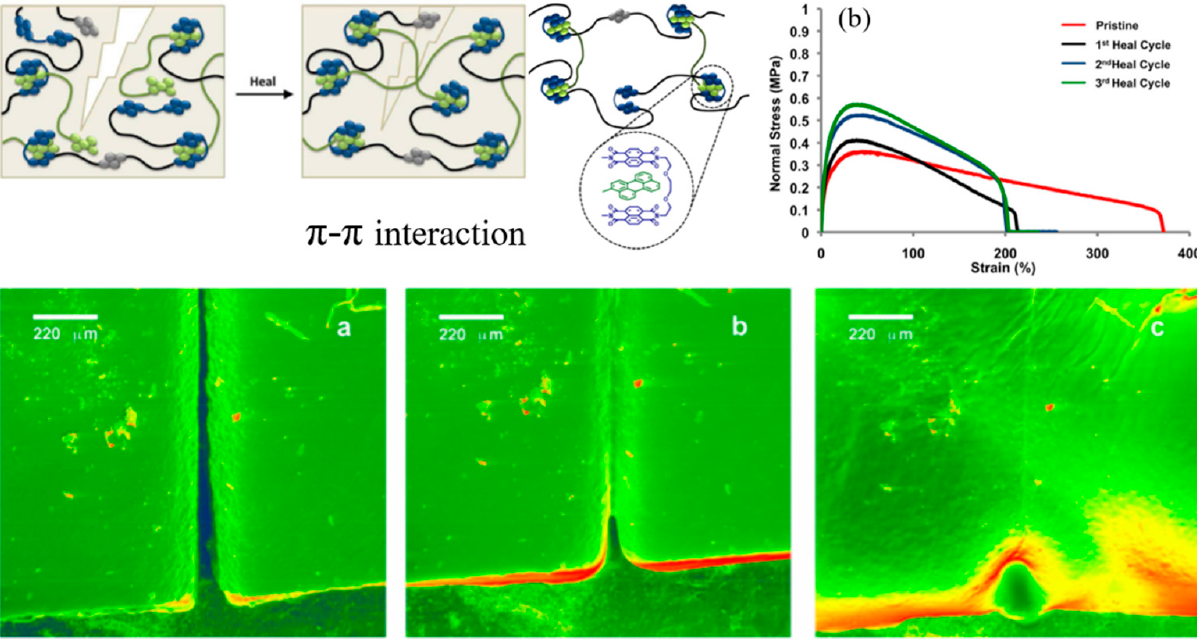
Table 4. Overview of characterization methods for π – π interaction.